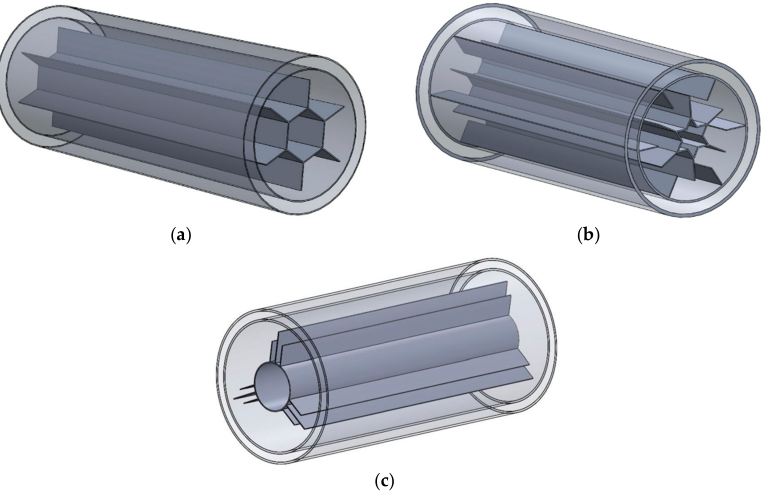
Figure 3. Different triplex tube heat storage units. ( a ) Hexagonal-shaped triplex tube [37]; ( b ) Star-shaped triplex tube [38]; ( c ) Triplets fins triplex tube [39]. (Permission to reproduce from Refs. [37–39]). Table 1. Application of rectangular fins in LHTES units.